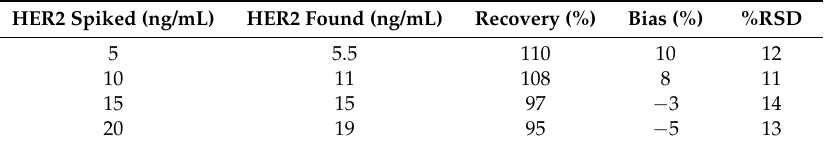
assay for HER2 detection; Figure S7: Schematic representation of affibody/antibody assay for HER2 detection. Table S1: Experimental parameters optimization for antibody/affibody assay; Table S2: Experimental parameters optimization for affibody/antibody